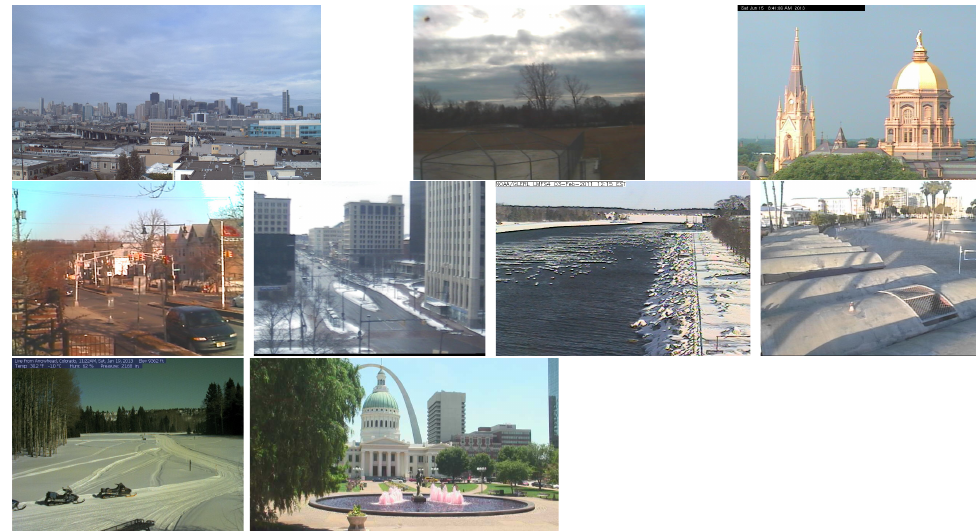
Figure 2. Sample images from the nine evaluated scenes.